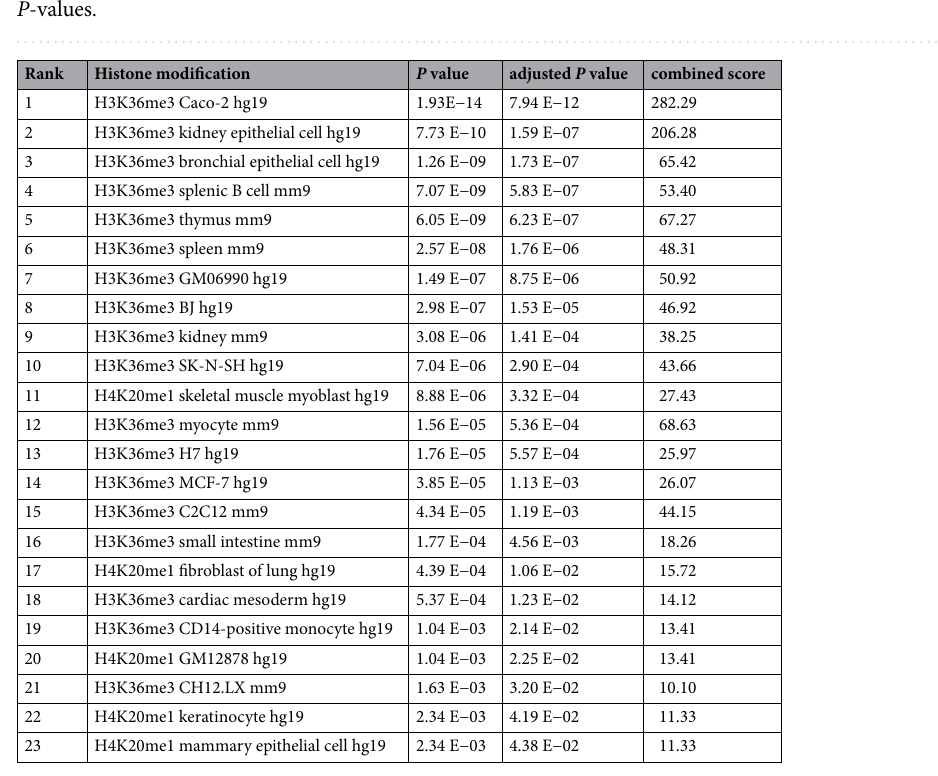
Table 2. Enriched histone modifications detected by Enrichr (ENCODE Histone Modifications 2015) for the 123 selected genes. Only those with adjusted P -values below 0.05 are listed